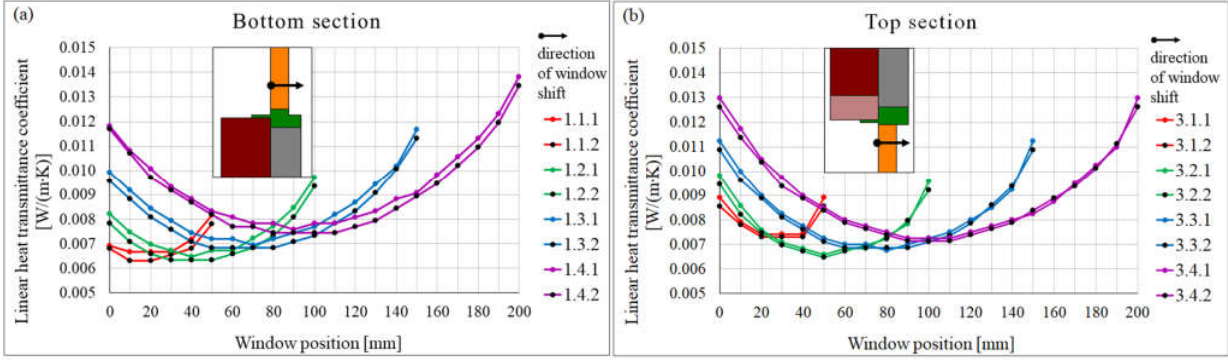
Figure 10. Linear heat transmittance coefficient for: ( a ) bottom, ( b ) top section—numerical calcula- tion results. calculation